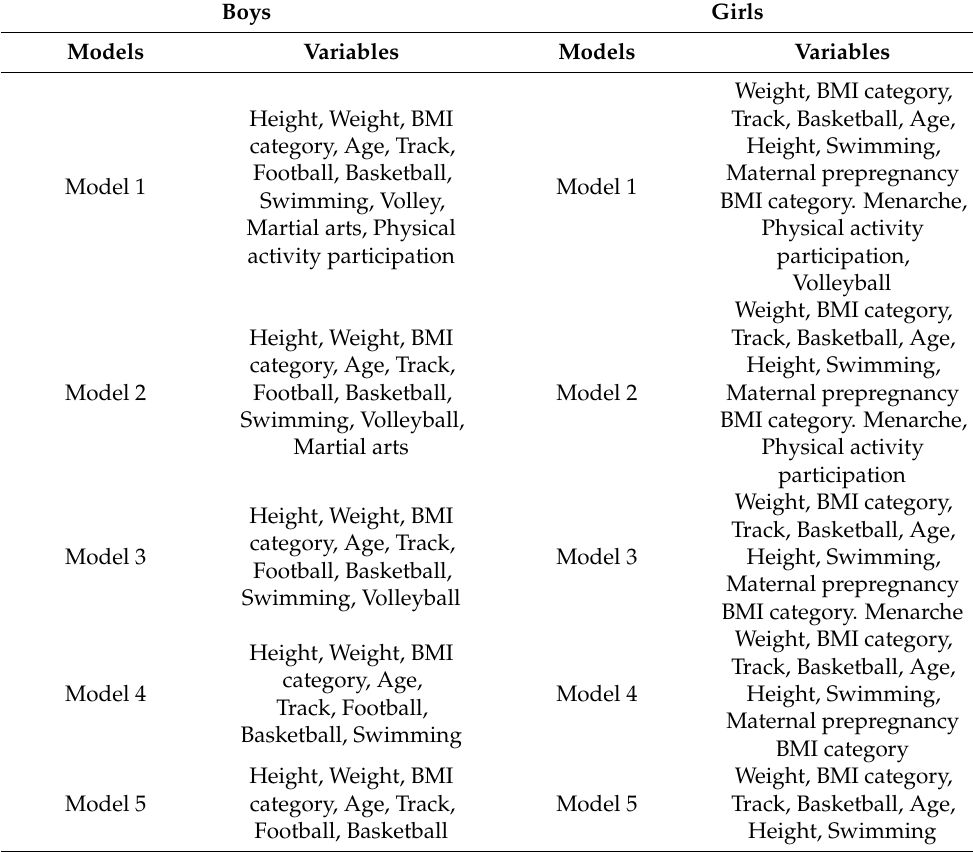
Table 2. Prediction models built for VO 2